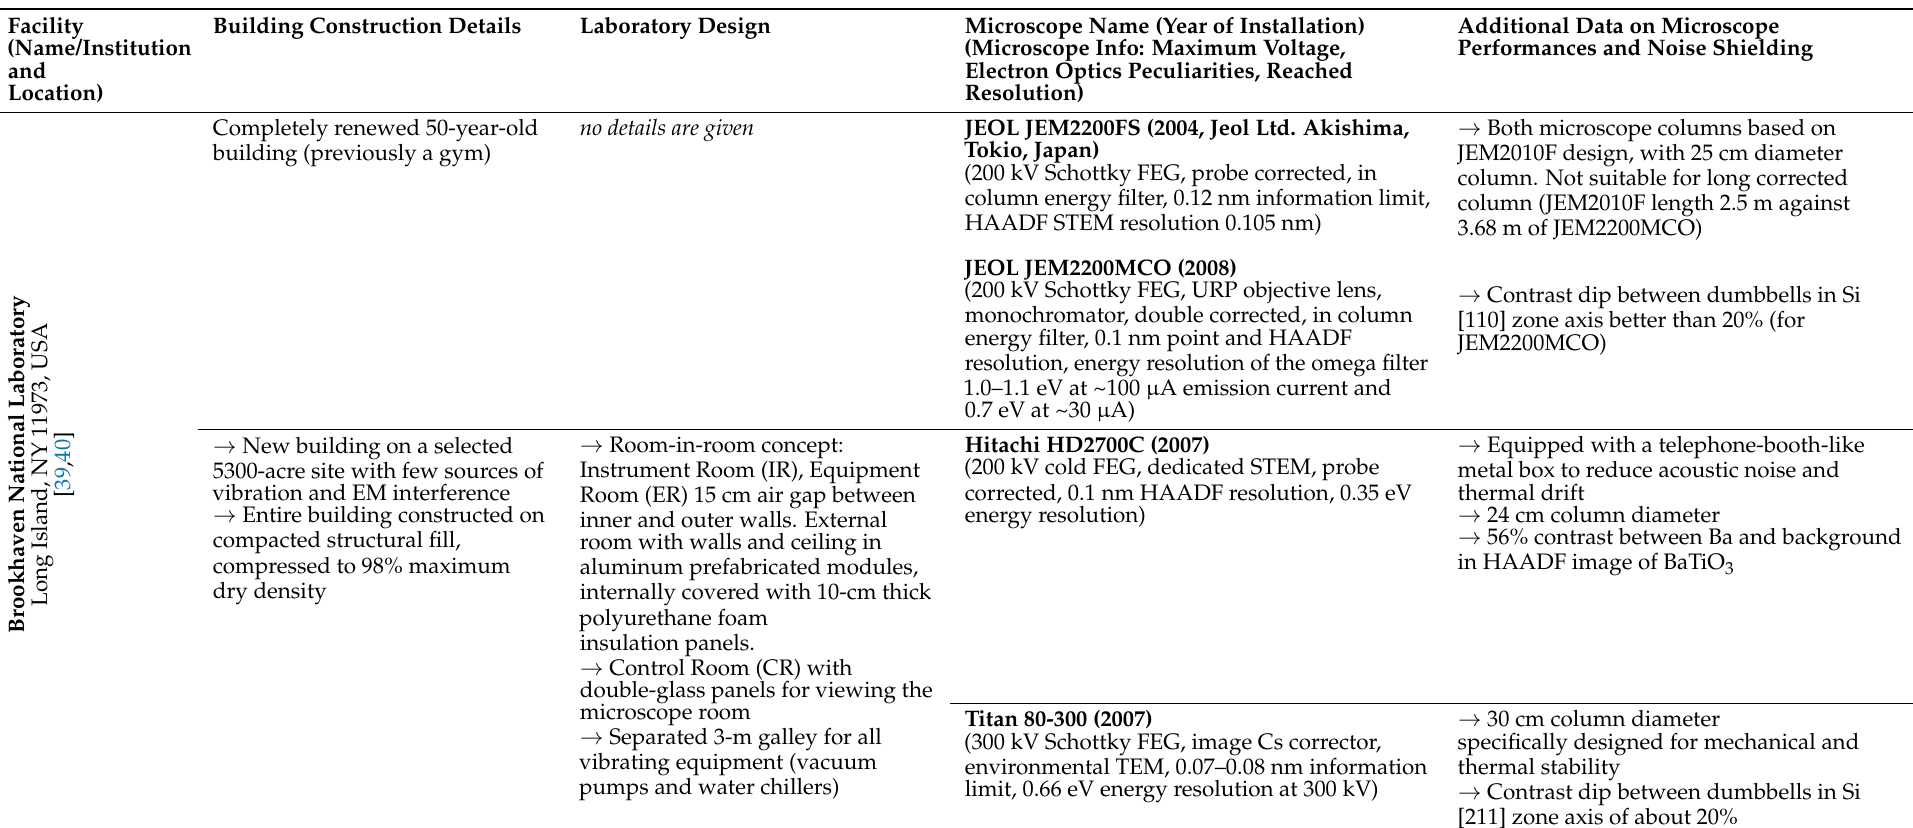
Table 1. Transmission electron microscopy facilities and relevant instrumentation, of which laboratory design and construction are discussed in the literature in dedicated articles or sections of articles. Here, details about the design of both building and laboratory hosting advanced TEM/STEM instrumentation are synoptically reported, together with the main characteristics of the